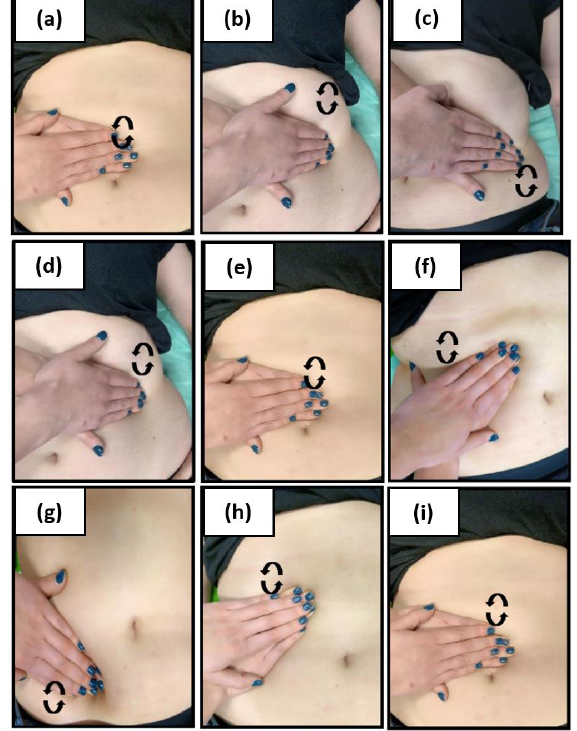
7 of 14 Figure 4. Manual lymphatic drainage of the abdomen; effleurage: during inhalation, rotary tech- nique from the pubic bone to the sternum ( a ); during exhalation, rotary technique from the costal